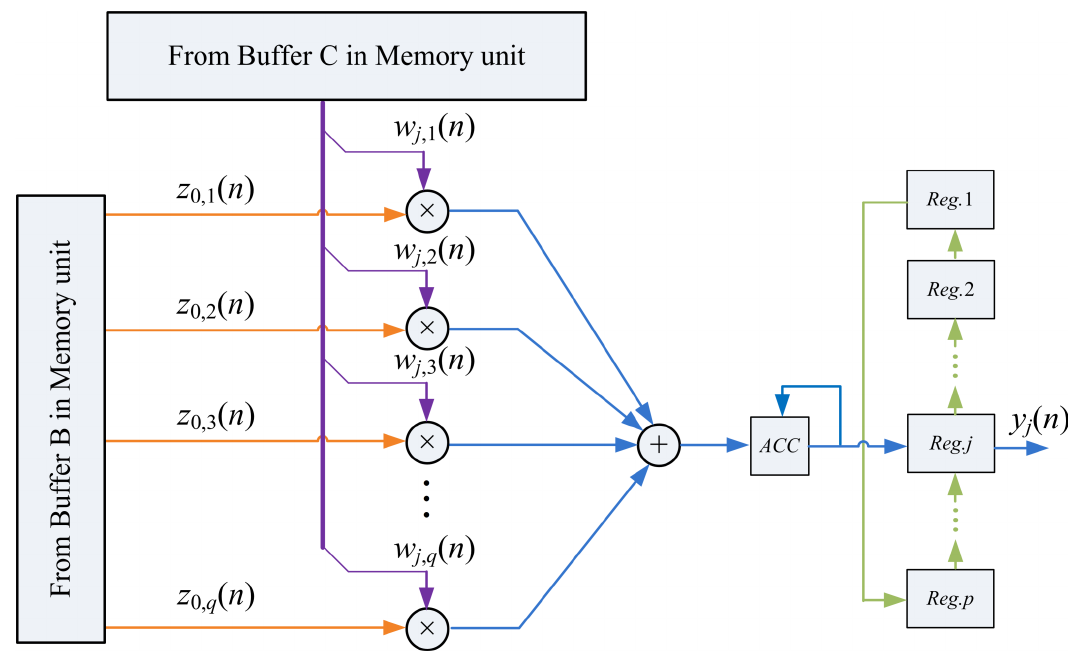
Figure 6. The PCC unit